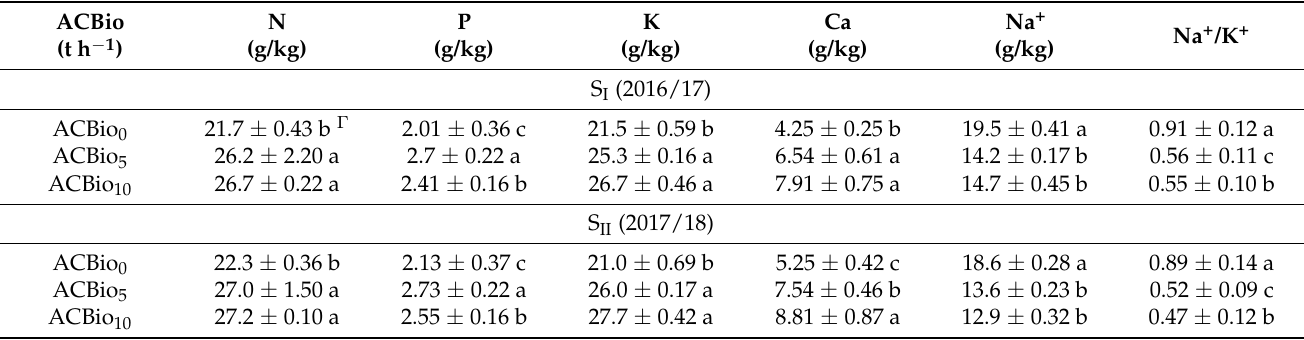
Table 4. Effect of acidified biochar rates on nutrients status (N, P, K Ca, Na, and Na + /K + ratio) of faba been plants for S I (2016/17) and S II (2017/18)